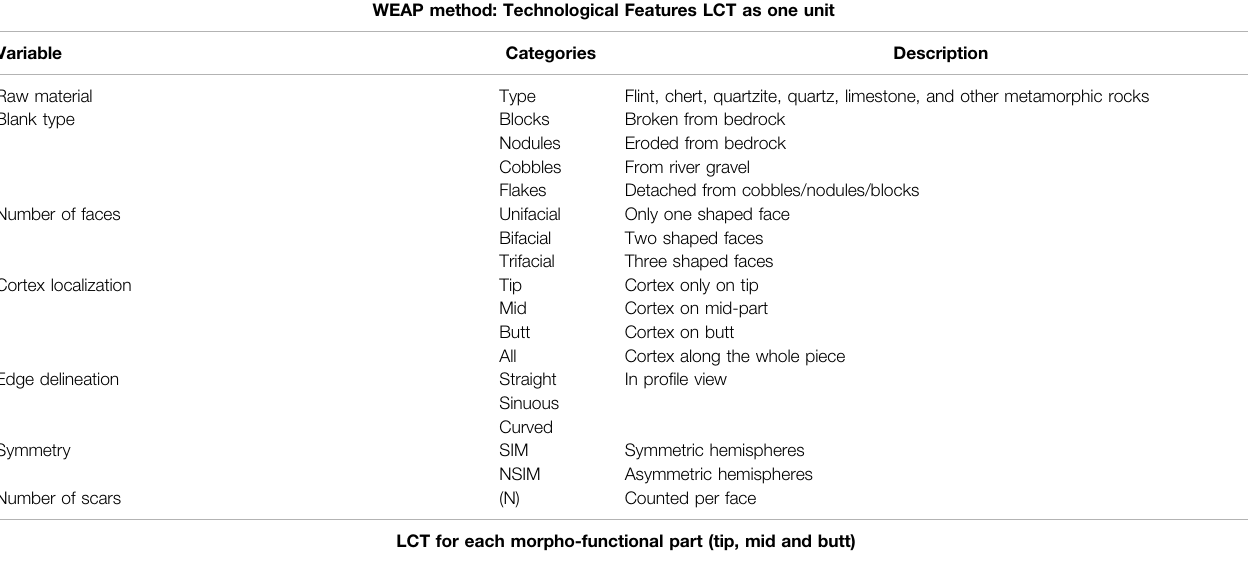
TABLE 1 | Technological features and linear measurements considered to analyze LCT according to the WEAP Method. WEAP method: Technological Features LCT as one